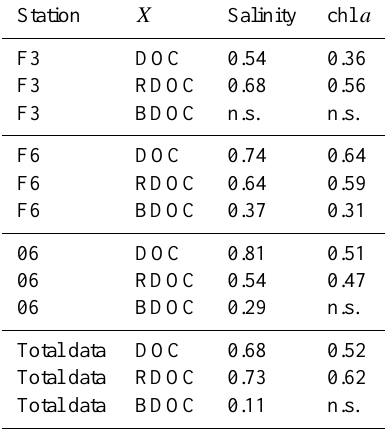
Table 4. Correlation coefficients ( R 2 ) of the significant ( p < 0 . 05) linear regressions between DOC and hydrological data in Tokyo Bay (stations F3, F6, 06, and total data). X indicates dependent vari- able. N.s. indicates not significant. Station X Salinity chl a F3 DOC 0.54 BDOC n.s.